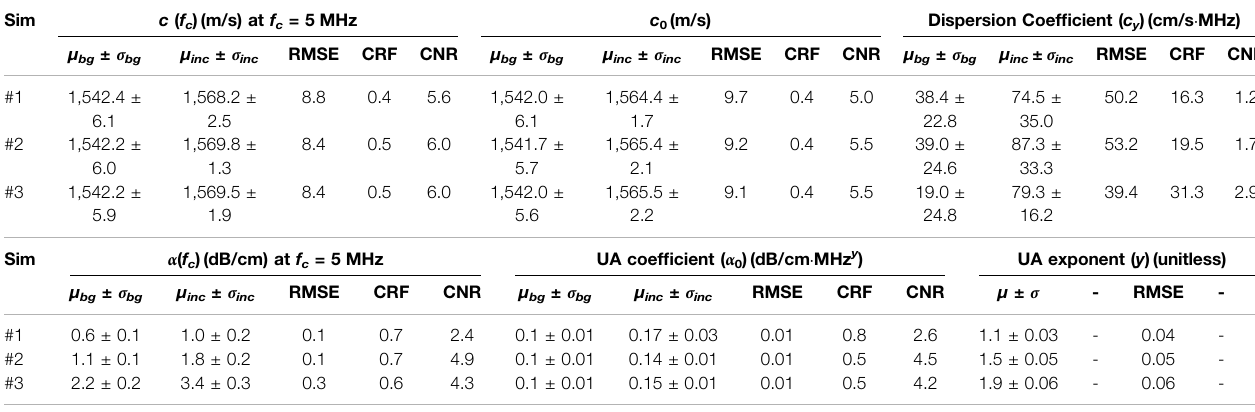
TABLE 1 | Quantitative evaluation of SoS and UA frequency-dependent model parameter reconstructions for simulations. μ bg and σ bg are mean and standard deviation of background, μ inc and σ inc are mean and standard deviation of inclusion. Sim